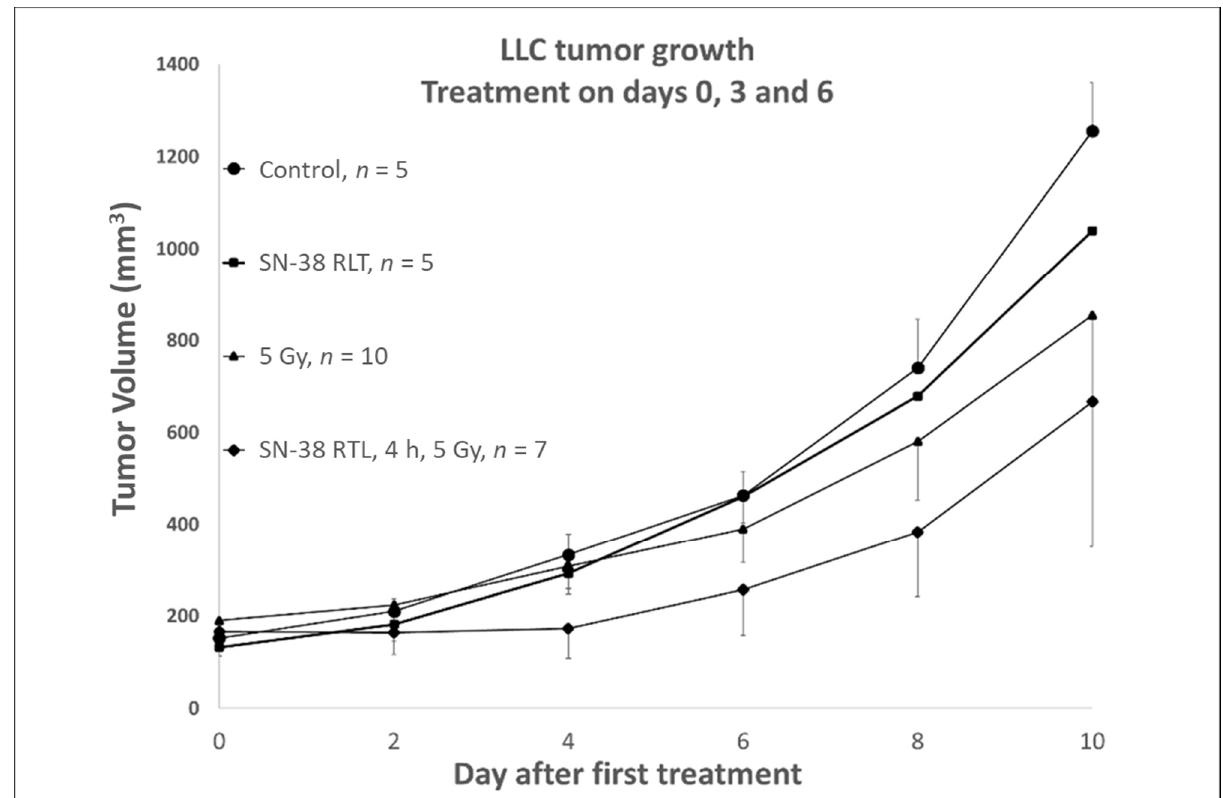
Figure 6. Tumor growth delay compared to untreated (control) LLC tumors grown in the rear limb of C57 mice. Groups contained 5–10 individually treated mice and the data is plotted as the mean with SD. SN-38 2 mg/kg or RTLs loaded with SN-38 corresponding to 2 mg/kg were injected IV on days 0, 3 and 6. Radiation was administered to the tumor at a dose of 5 Gy on days 0, 3 and 6. In the combined treatment group, RTLs (SN-38) were given IV at 2 mg/kg and 4 h after injection the tumor was irradiated with 5 Gy. The average tumor volume at days 2–8 after the start of treatment in the combined therapy group was significantly lower ( p < 0.0002–0.04, Student’s t -test comparing average fold change in tumor volume) than either monotherapy or control group. By day 10, the last day of measurement, the tumors had all started to regrow at a similar rate since therapy had ended on day